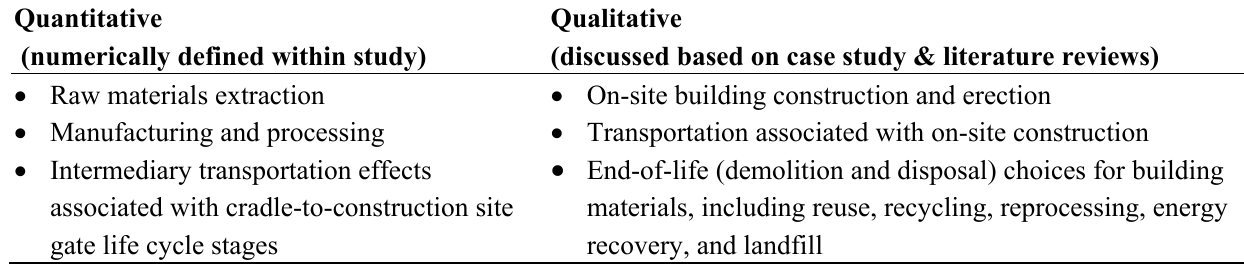
Table 1. Quantitative vs . qualitative analyses of life cycle stages.